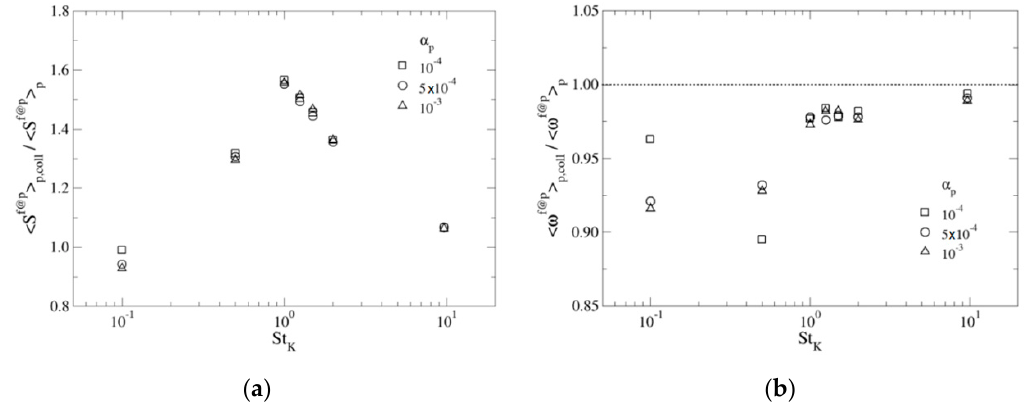
Figure 9. ( a ) Average of sampled fluid strain rate by colliding pairs over mean sampled fluid strain rate by all the particles. ( b ) Average of sampled fluid vorticity of colliding particles over mean sampled fluid vorticity. Both variables are presented as a function of particle Stokes number for the three evaluated average volume fractions.